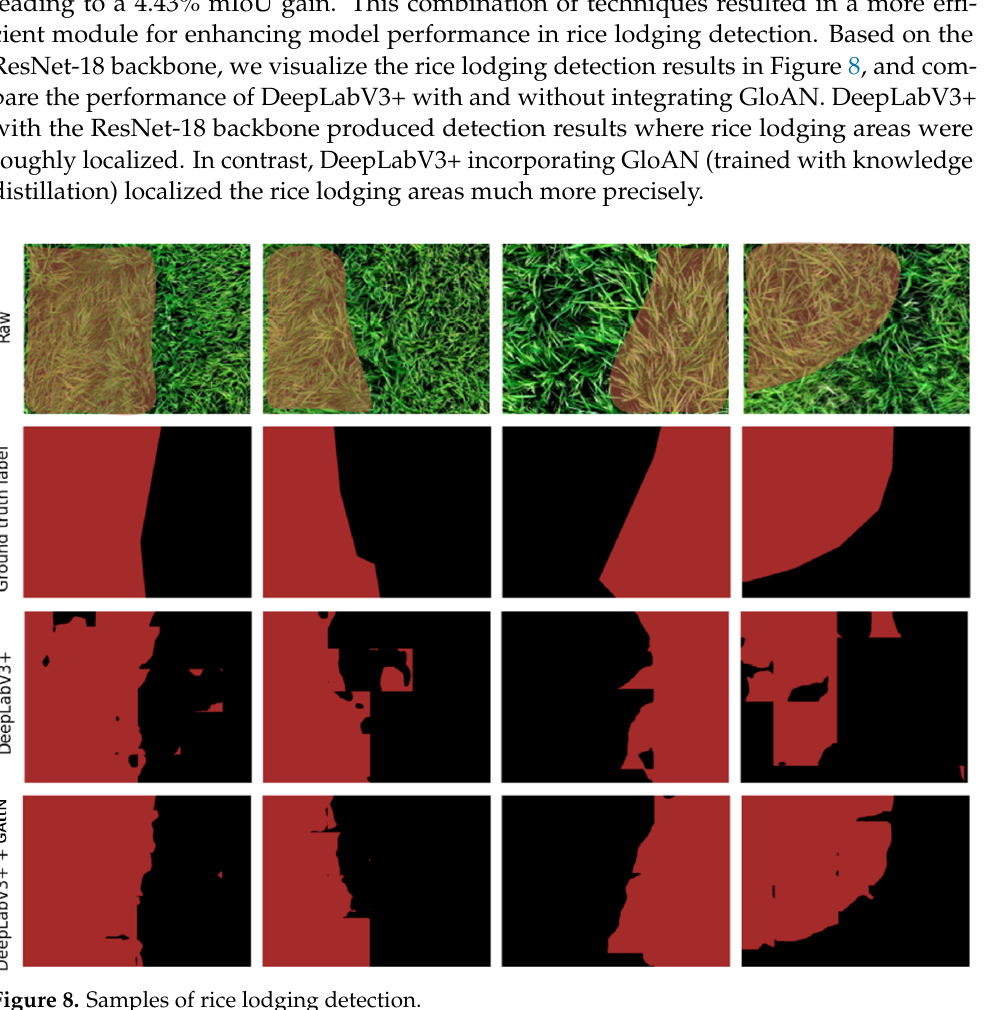
Figure 8. Samples of rice lodging